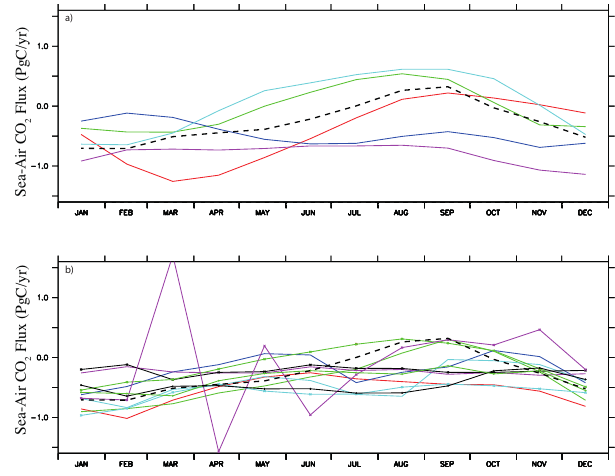
1232$ 1233$ Fig. 7. The seasonal sea–air CO 2 fluxes for the Southern Ocean (44–75 ◦ S) from individual ocean biogeochemical models (upper) Figure 7 The seasonal sea-air CO 2 fluxes for the Southern Ocean (44 ° S-75 ° S) from 1234$ and individual atmospheric inverse estimates (lower). In both plots individual ocean biogeochemical models (upper) and individual atmospheric inverse 1235$ the observations are overlain (dashed black line). Negative values estimates (lower). In both plots the observations are overlain (dashed black line). 1236$ reflect flux into the Negative values reflect flux into the ocean. 1237$